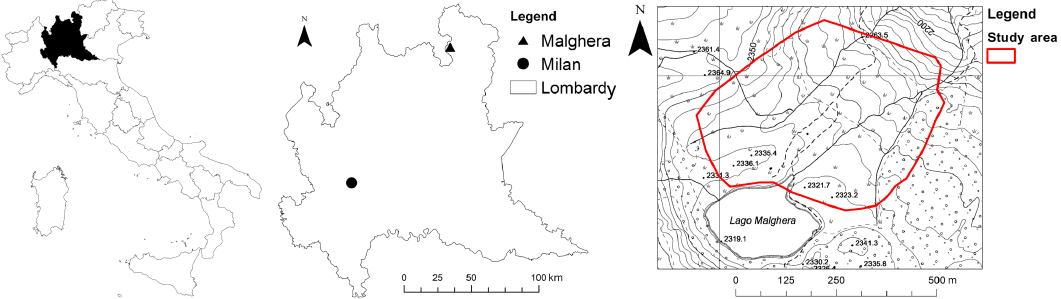
Figure 1. Location of the study area in western Val Grosina Valley, Lombardy region, northern Italy. The right panel shows a topographic map of the area, with isolines every 10m and the elevation (in meters) of some points of interest. Topographic map from http://www.geoportale. regione.lombardia.it/.